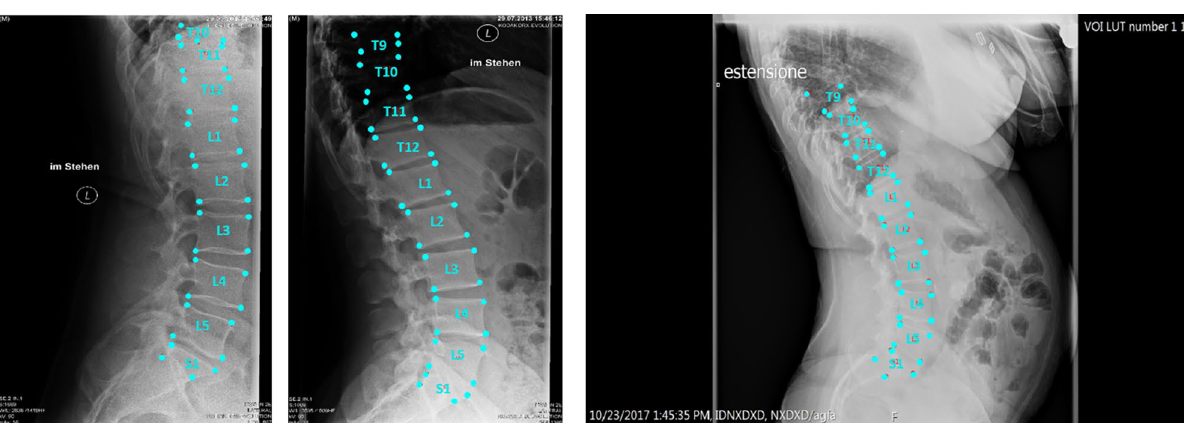
many of these cases, understanding where the vertebrae are located would be difficult even for an expert human observer (Fig. 4). The quantitative analysis confirmed the performance of our 2-step model in the vertebral corners localization. The accuracy in detecting vertebrae was 98.4%. A vertebra is correctly detected when the CNN 1 label it cor- rectly as L1, L2 etc. so the accuracy is computed as the ratio between the correctly labeled vertebrae and the total number of vertebrae. The analysis of the absolute error between the ground truth and the predictions revealed that, in general, the model was equally accurate in the localization on both the x-axis and the y-axis (Fig. 5). The medians of the absolute errors, except for T9, are below 4% of the vertebral width indicating good performance both for x and y. It should be noted that T9 and T10 were underrepresented in the training set, thus explaining the slightly worse performance in correspondence of these vertebrae . For S1, the medians of the x and y errors were 2.44% and 2.38% of the vertebral width, respectively. The weighted means of the median errors (Eqs. (5, 6)) were 1.98% and 1.68% for x and y respectively (Table 1). The maximum errors in the estimation were 77%